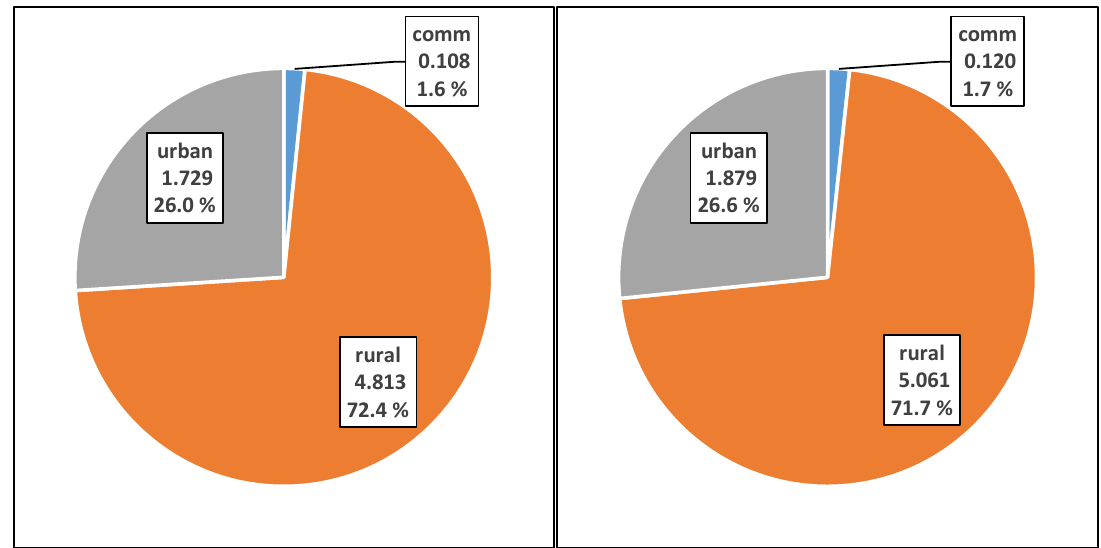
Figure 8. Energy Demand Mix in the Building Sector in Ref Scenario ( left ), and Alt-1 Scenario ( right ) in 2035 (Unit: EJ).